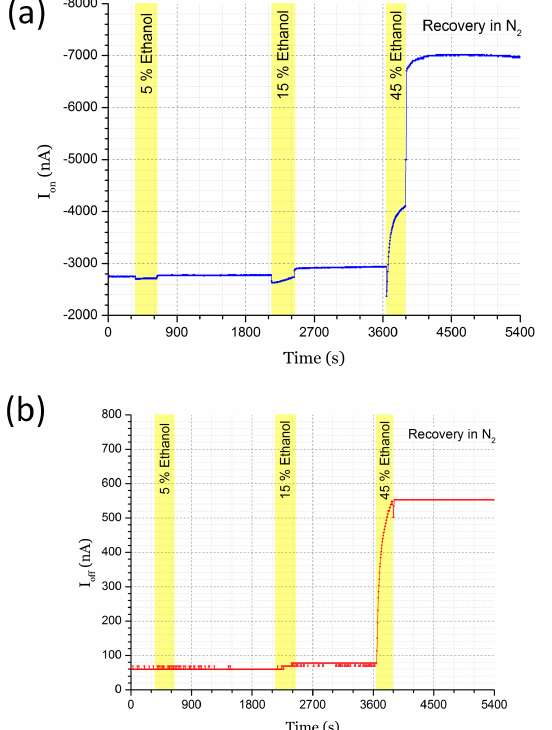
Figure 4. (a) I ON ( V DS = V GS = − 20V) under EtOH exposure/ recovery cycles. All white regions depict purge under 500sccm pure dry nitrogen. Shaded regions indicate exposure to different concen- trations of EtOH vapour. From left to right: 5% p sat (equivalent to 2750ppm), 15% p sat (8250ppm) and 45% p sat (24750ppm). (b) Similar for I OFF ( V DS = V GS = +